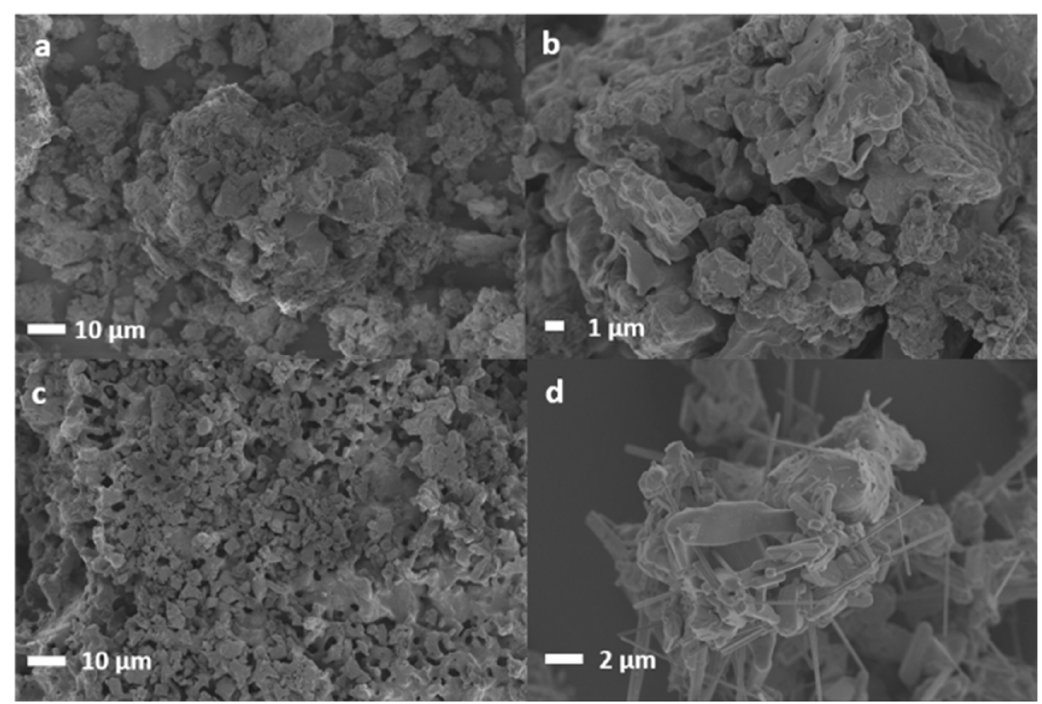
Figure 9. SEM of KB before ( a , b ) and after three carbonation/calcination cycles ( c , d ).